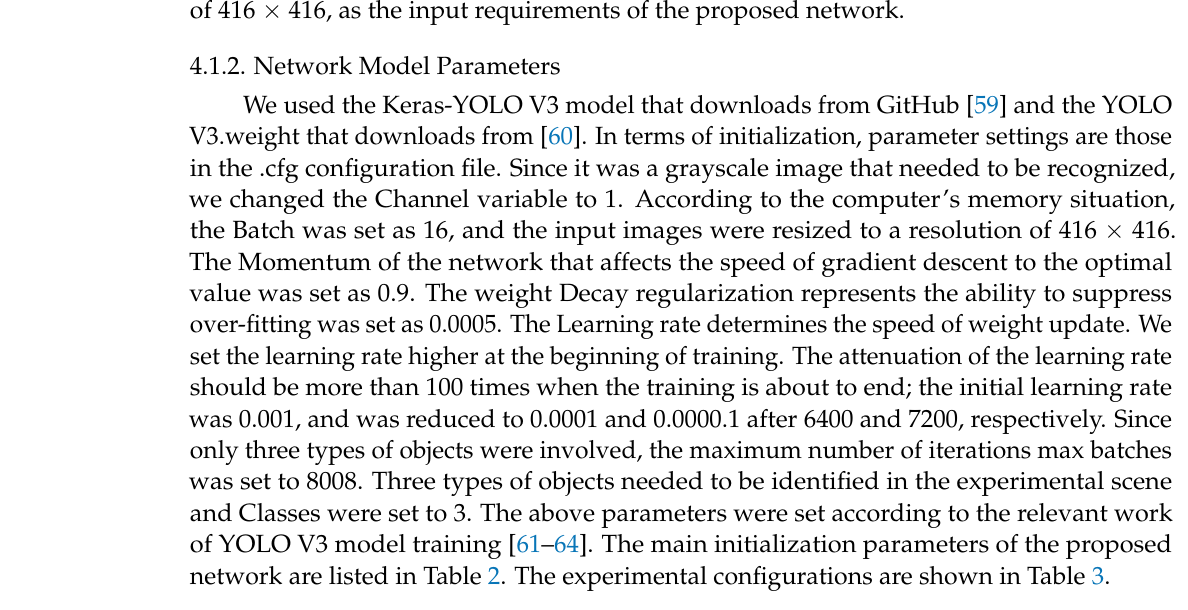
Table 2. Main initialization parameters of the proposed